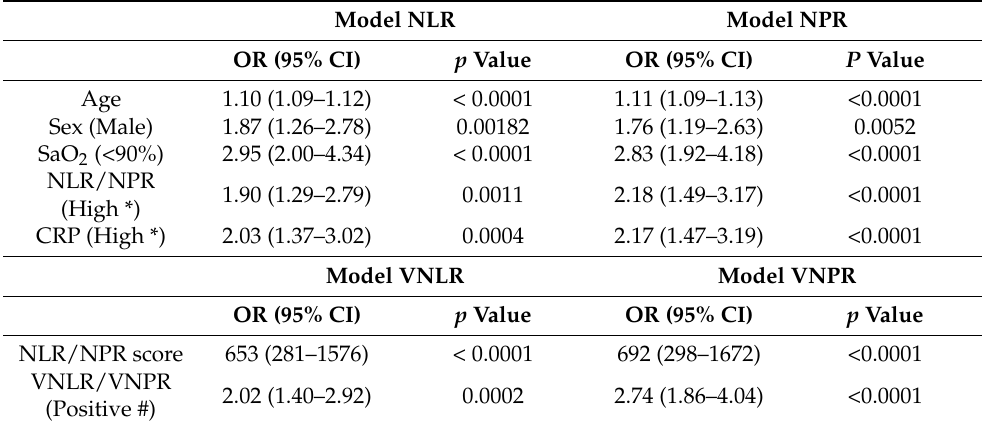
Table 3. Results from the multivariate logistic regression model for the models based in NLR and NPR.